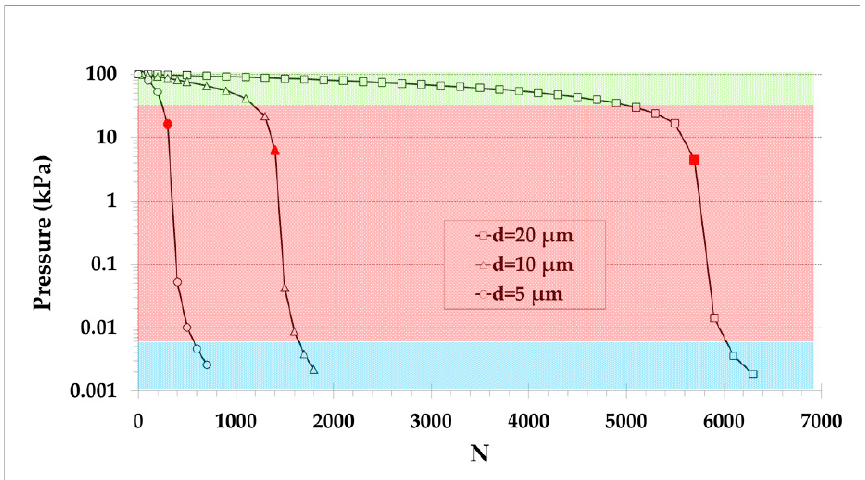
Figure 8. Inlet pressure evolution of a system connected to pump B as a function of its number of stages, considering narrow diameter channels d = 5,10, 20 µ m and a constant outlet pressure P out = 100 kPa (red solid symbols represent the pressure and stage number, where the maximum slope, corresponding to the peak values of Figure 5a, is observed).